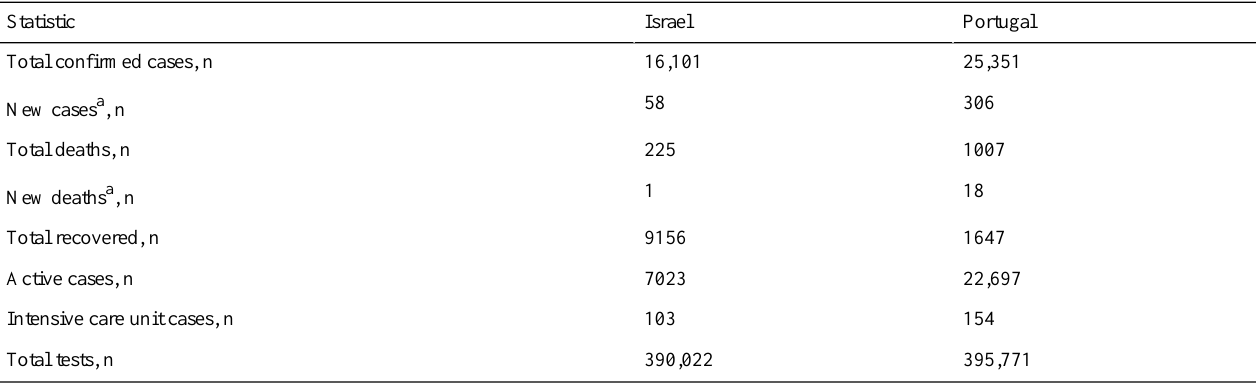
Table 1. Coronavirus disease summary statistics for Israel and Portugal, as of May 1,